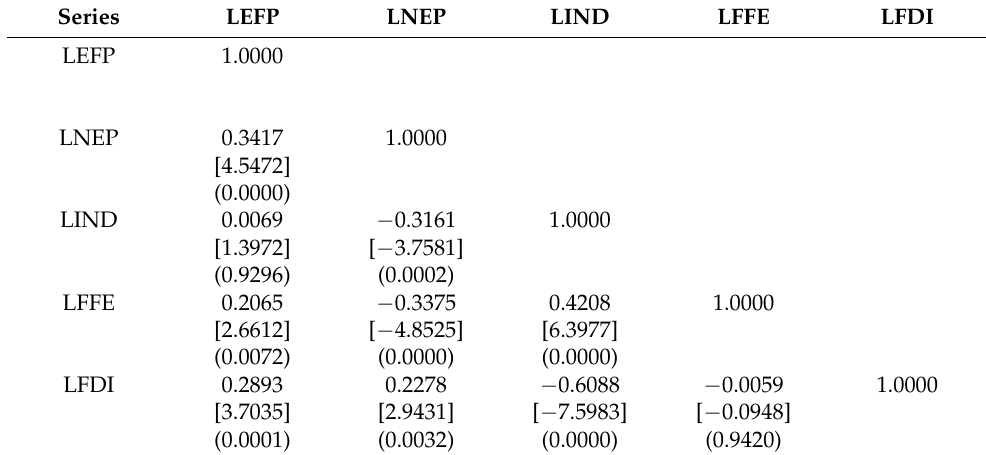
Table 3. Correlation